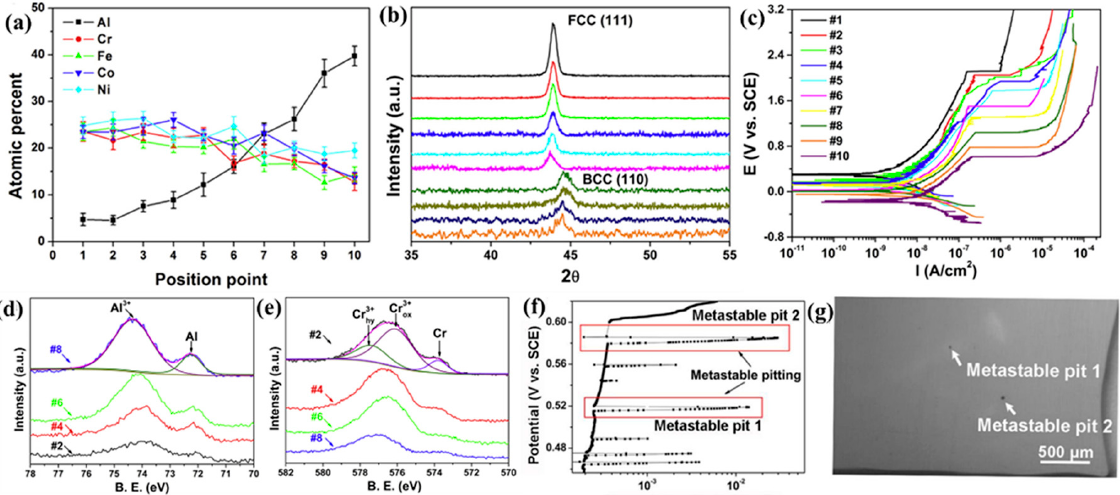
Figure 5. The polarization behaviors, surface chemistry, and pitting corrosion behaviors of Al x (CoCrFeNi) 1 − x HEAs. ( a ) Chemical compositions vs. number of samples (spots 1 to 10); ( b ) XRD diffraction patterns of Al–containing HEA samples; ( c ) polarization plots of the ten HEA samples; #1–10 represent the Al x (CoCrFeNi) 1 − x HEAs in ( a ); ( d ) Al 2p, ( e ) Cr 2p3/2 spectra of #2, #4, #6, and #8 HEA samples after immersion in 3.5 wt.% NaCl aqueous solution for 24 h; ( f ) enlarged current fluctuation of potentiodynamic polarization curves for Al 0.3 CoCrFeNi, red boxes presents the enlarged current fluctuations; ( g ) corrosion micrograph after the polarization test at 0.6 V SCE [25,46].